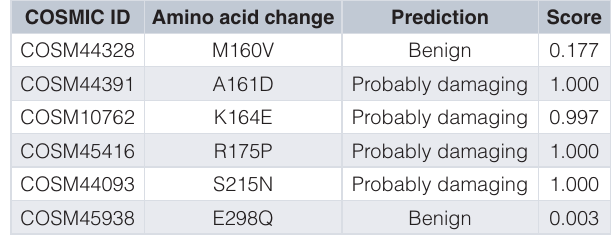
Table 4. Prediction of functionally significant nsSNPs by PolyPhen 2.0 algorithm.